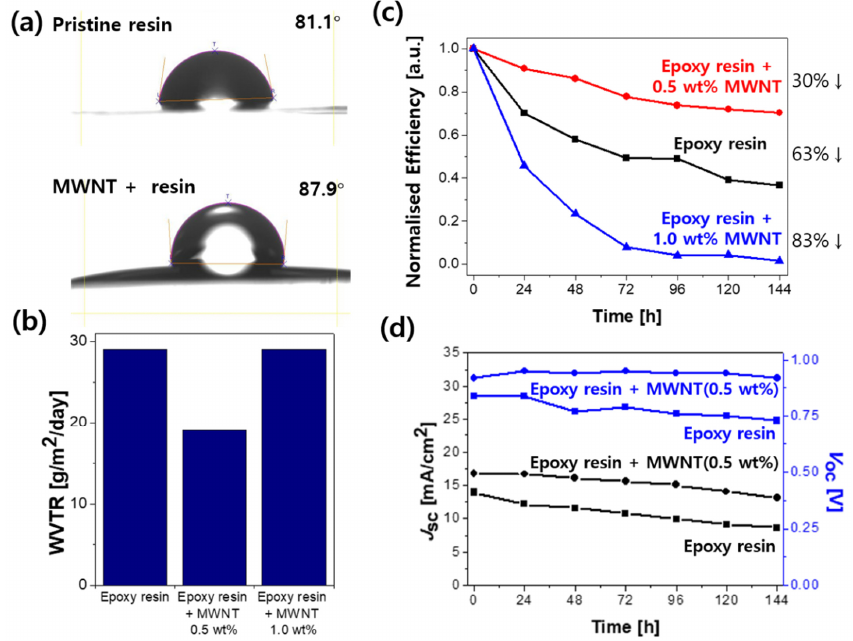
Figure 4. ( a ) Water contact angle of the pristine and MWNT-added UV epoxy resin; ( b ) WVTR of the MWNT-added UV epoxy resin; ( c , d ) Changes in ( c ) the normalised efficiency; ( d ) J SC and V OC of the encapsulated PSCs without (control device) and with MWNT added to the UV epoxy resin during the stability test under constant device operation.